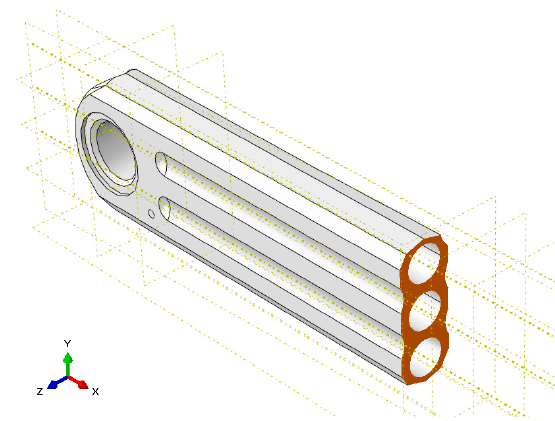
Figure 12. Numerical model of the crank arm sectioned in the YZ plane.